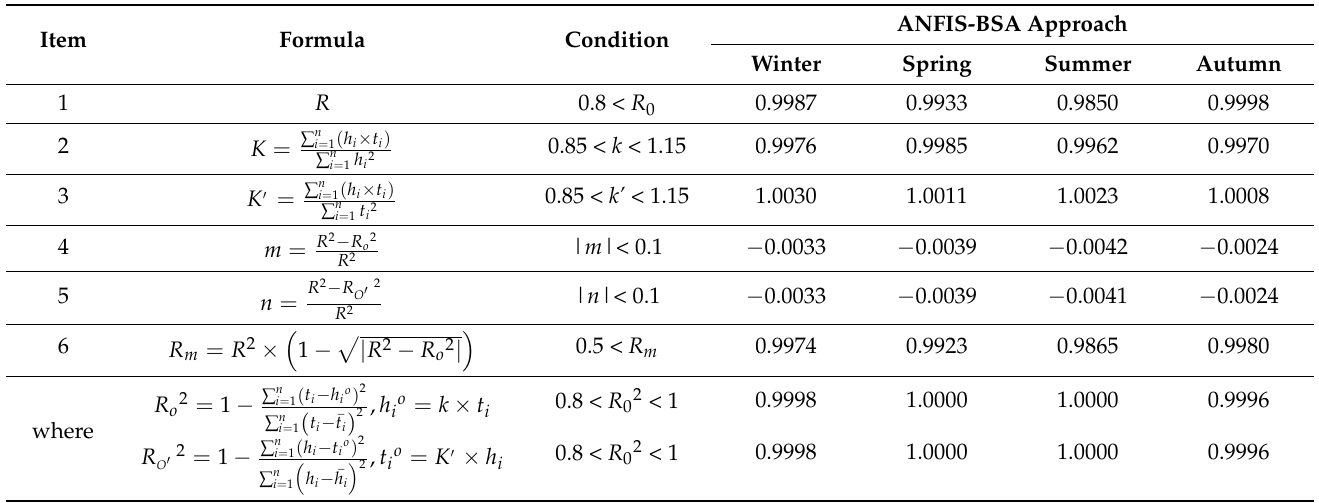
Table 10. ANFIS-BSA model’s statistical factors for EPF in one month of winter, spring, summer and autumn 2018 for